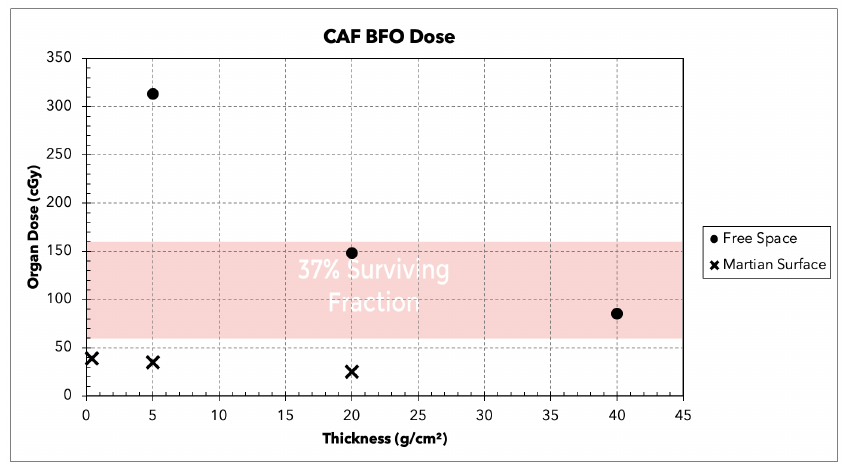
Figure 5. BFO doses from 993/4 SPE for CAF behind various thicknesses of aluminum shielding. The possible biological damage threshold region is labeled in the